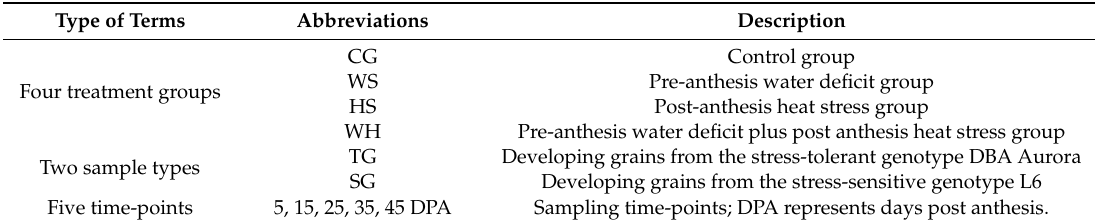
Table 1. Summary of the abbreviations used for sample names and library